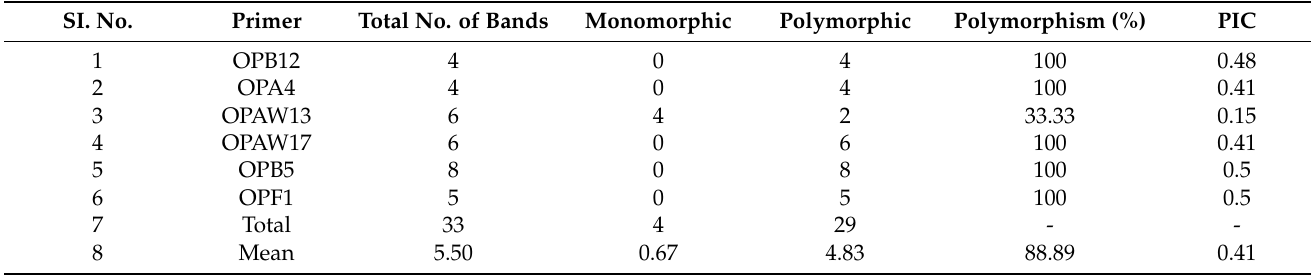
Figure 5. Variations in phenotypic characters of in vitro plantlets at 10, 20 and 40 Gy gamma radiation treatments. Protocorm-like bodies (PLBs) of Dendrobium ‘Emma White’ were irradiated with gamma rays of 10, 20, 40, 60 and 80 Gy and incubated at 22 ± 2 °C and 65–70% relative humidity with 16 h photoperiod. After 11–12 months of irradiation, differential phenotype of regenerated plantlets at 10, 20 and 40 Gy doses were recorded concerning plant growth attributes ( A ) plant height, ( B ) leaf length, ( C ) leaf number, ( D ) leaf width, ( E ) root number, ( F ) root length and root width. No significant difference in root width was observed under all the responsive treatments. Data represent mean value ± standard deviation ( n = 10). Mean values with different lower-case letters (a, b, c, d) are significantly different at p < 0.05 (Duncan’s Multiple Range Test). Table 3. Random amplified polymorphic DNA (RAPD) banding pattern analysis in gamma-ray- induced mutant plantlets at doses 10, 20 and 40